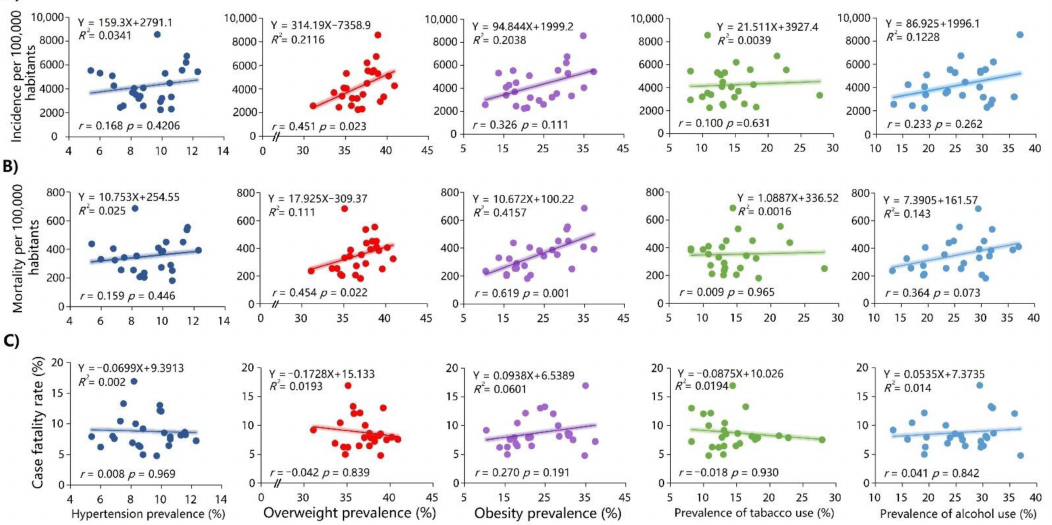
Figure 3. Linear regression models and Spearman correlation between the prevalence rates of hypertension, overweight, obesity, smoking, and alcohol use and the incidence rate ( A ), mortality rate ( B ), and case fatality rate due to COVID-19 ( C ) in 2021.